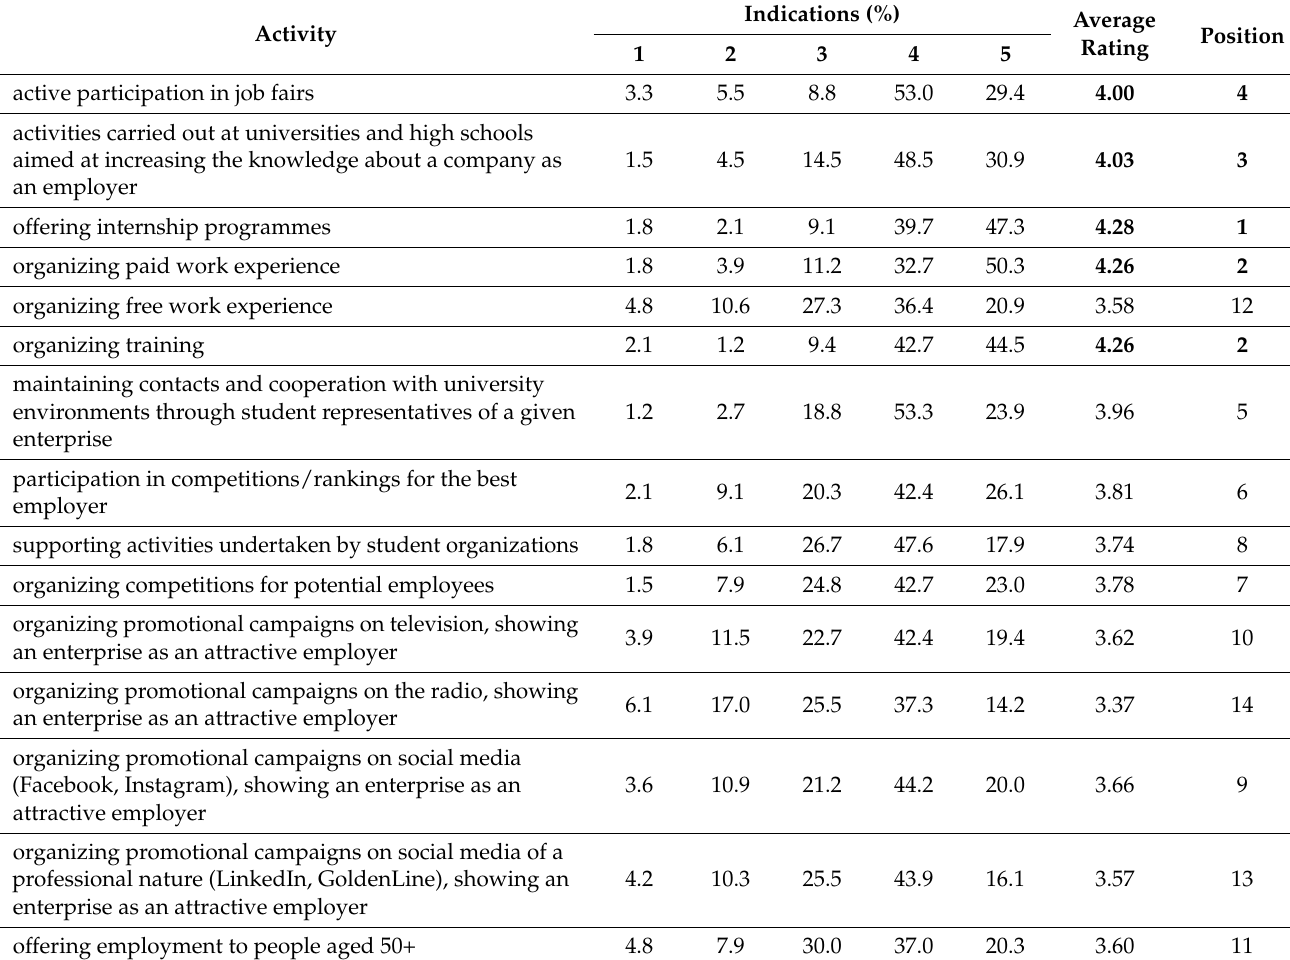
Table 1. Respondents’ opinions on the impact of activities undertaken by enterprises on shaping enterprises’ positive external image as an